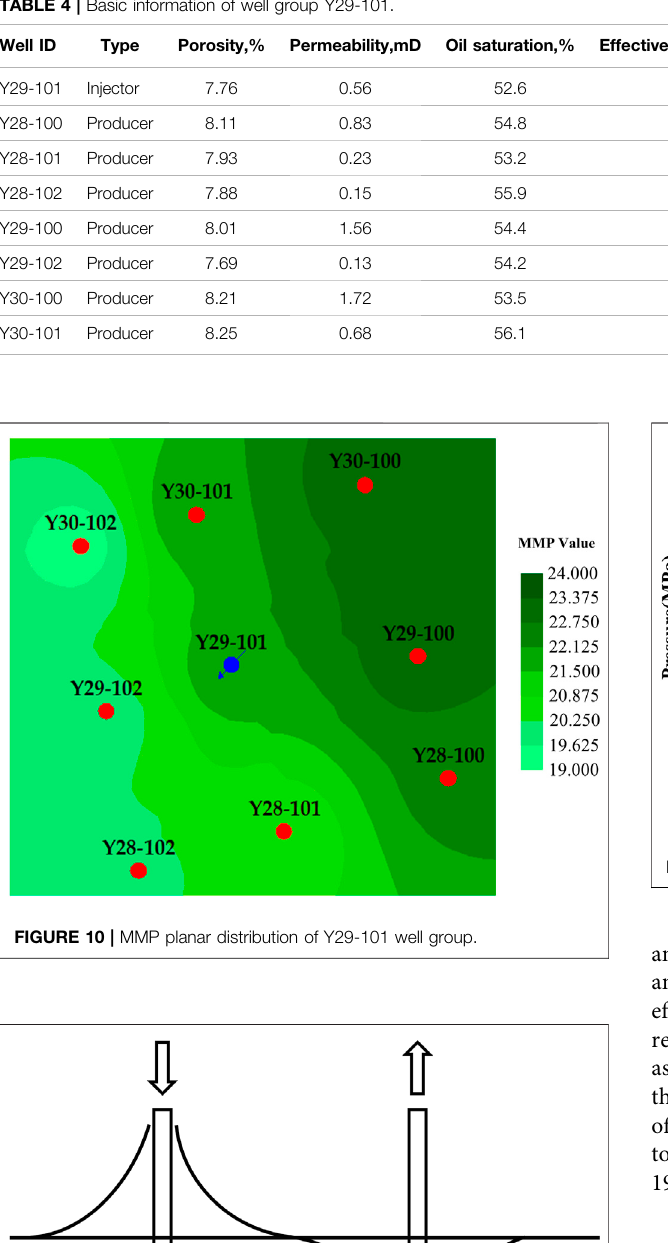
TABLE 4 | Basic information of well group Y29-101.